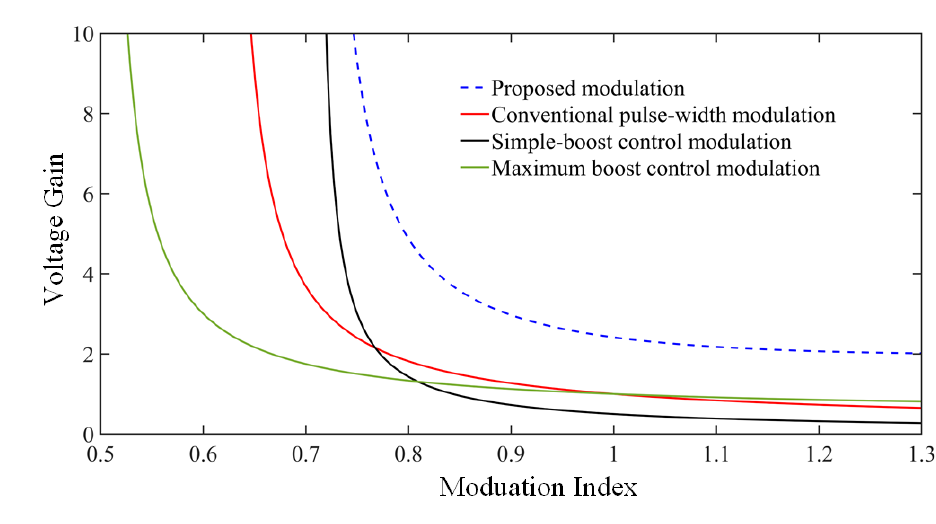
Figure 3. Voltage gain comparison. These plots are obtained through a MATLAB/Simulink model of the proposed